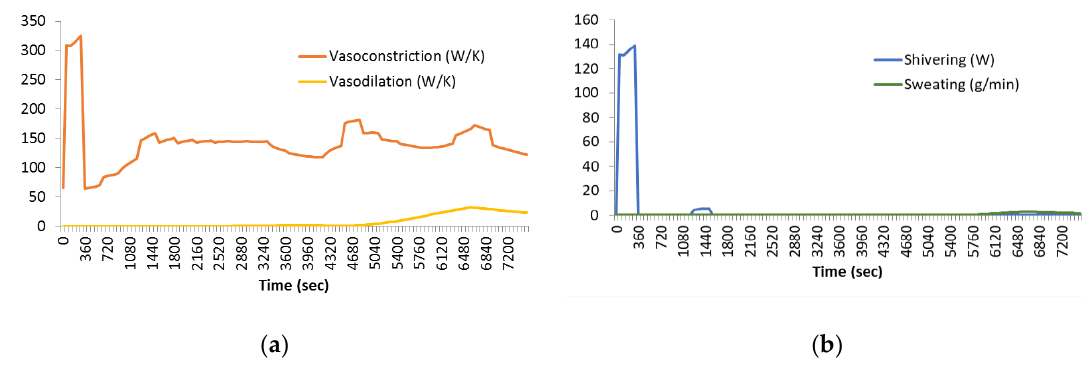
Figure 8. Functioning of active system during simulation; ( a ) shows the vasoconstriction and vasodilation and ( b ) shows the sweating and shivering.